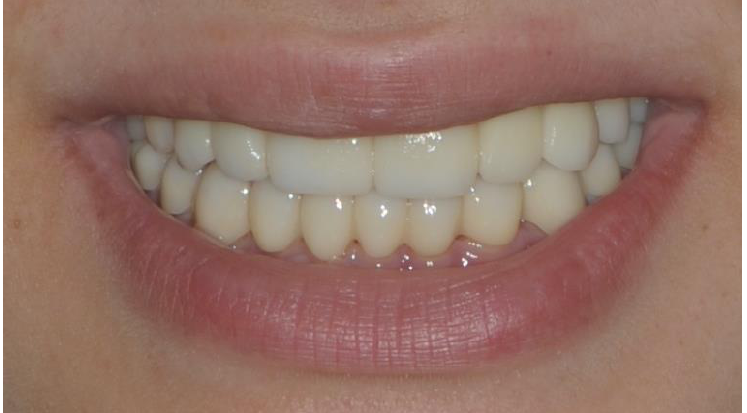
Figure 14. Case 4—Extraoral view of a young patient wearing DEFS, made of acetal resin.